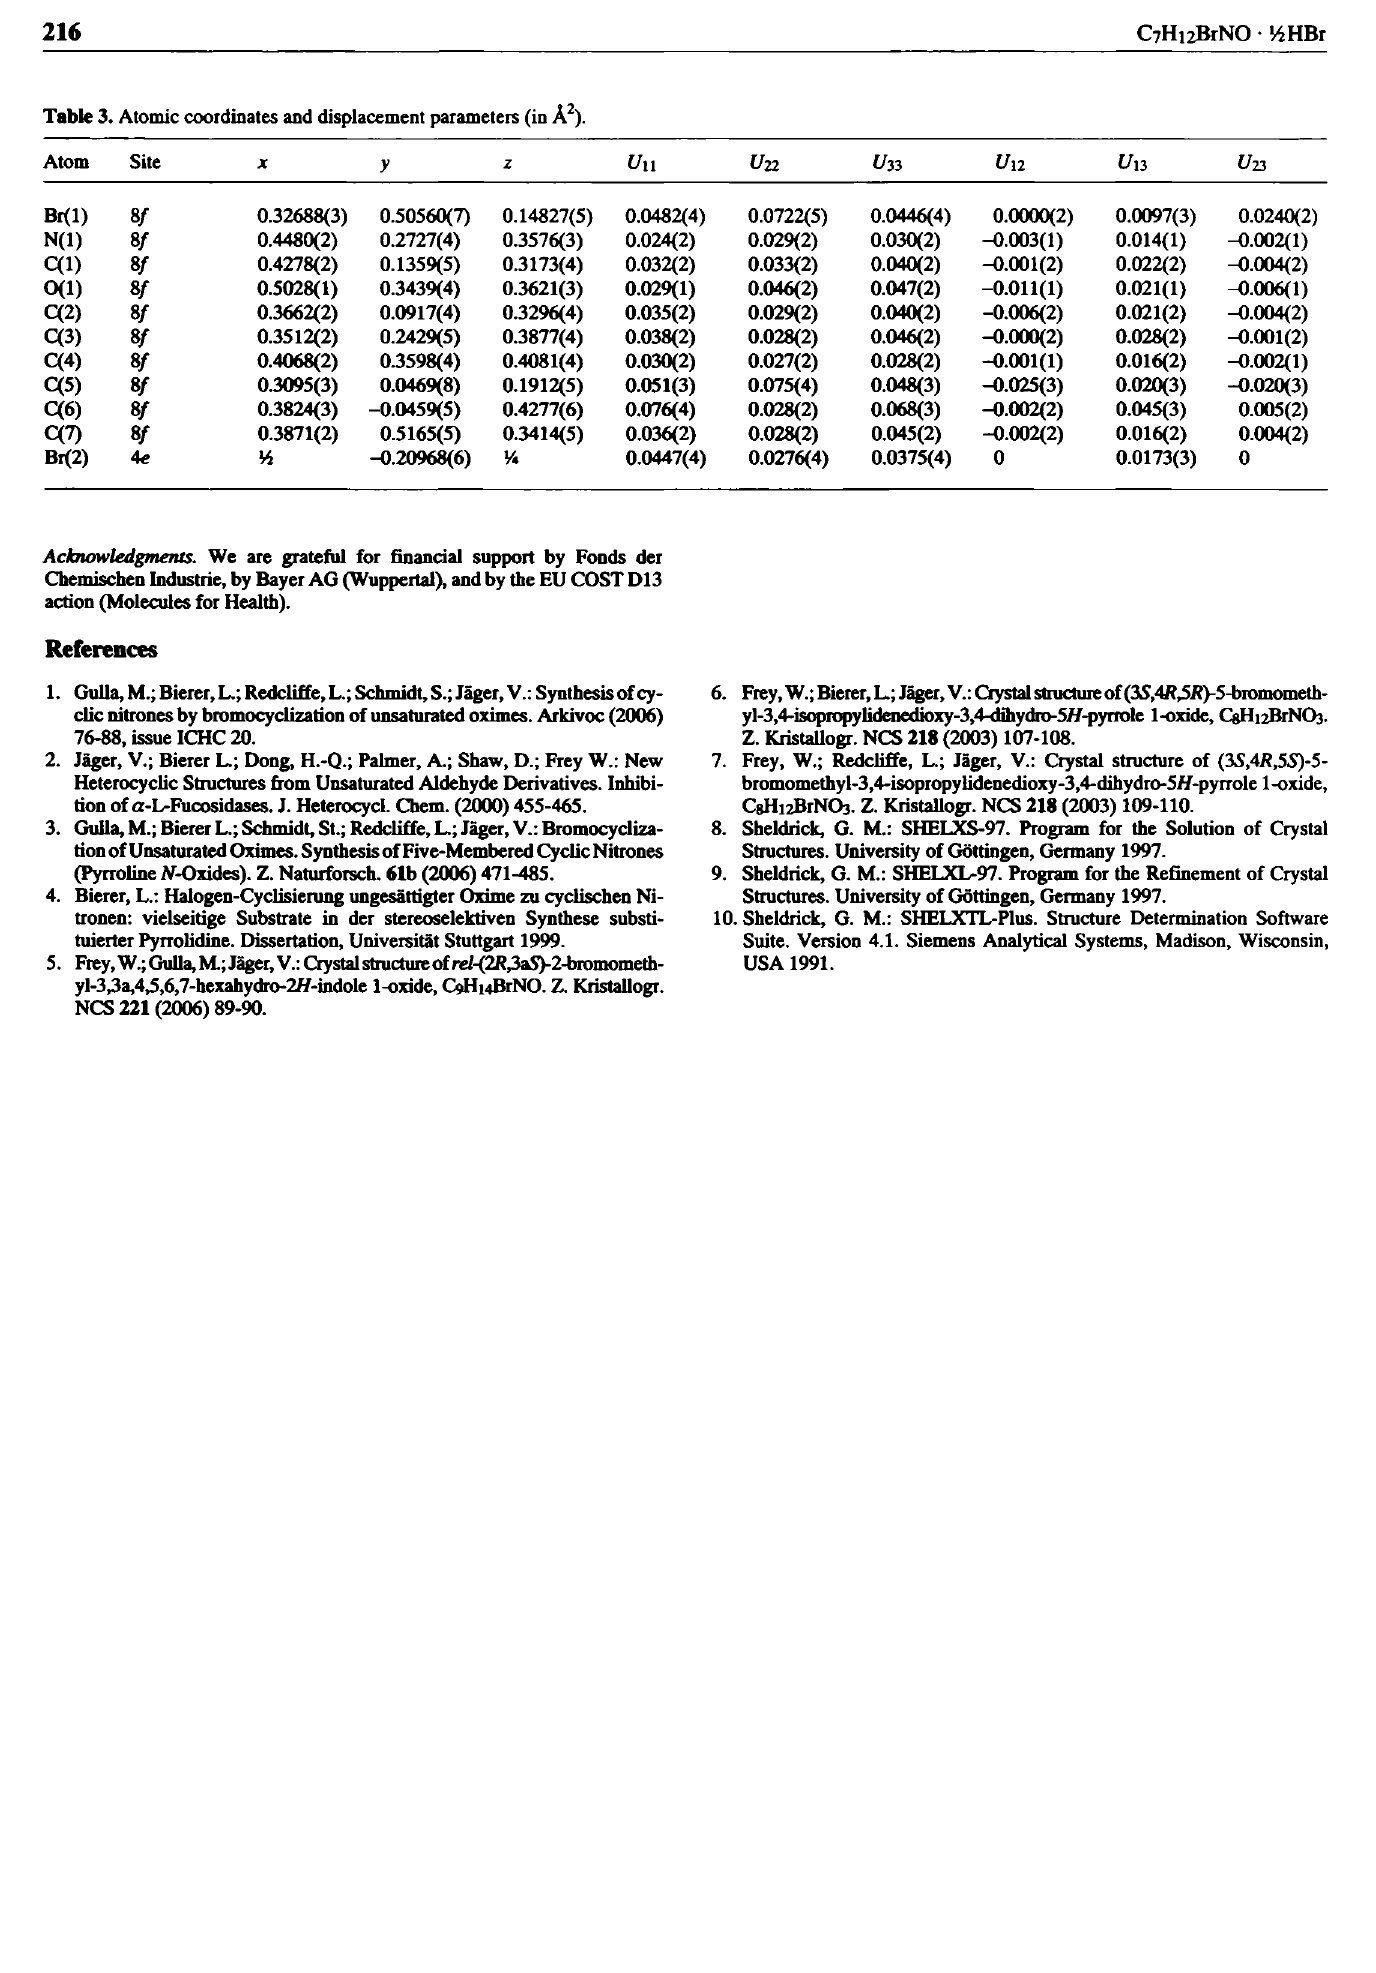
Table 3. Atomic coordinates and displacement parameters (in A 2